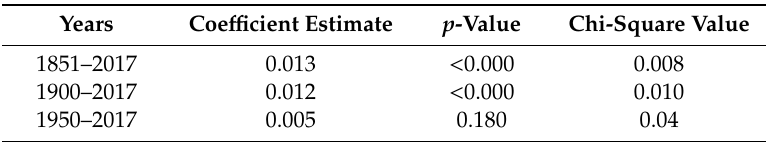
Table 6. Coefficient estimates, p-values, and chi-square p-values on the residual deviance for RI storms initiating their first cycle of RI within the North Atlantic sub-basin.